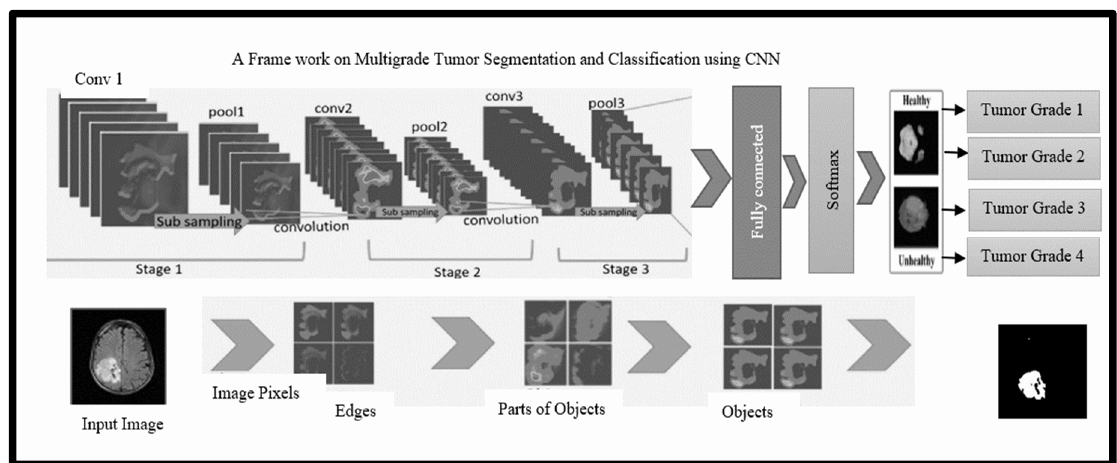
Figure 5. The framework on multigrade tumor segmentation and classification using the CNN net- work.